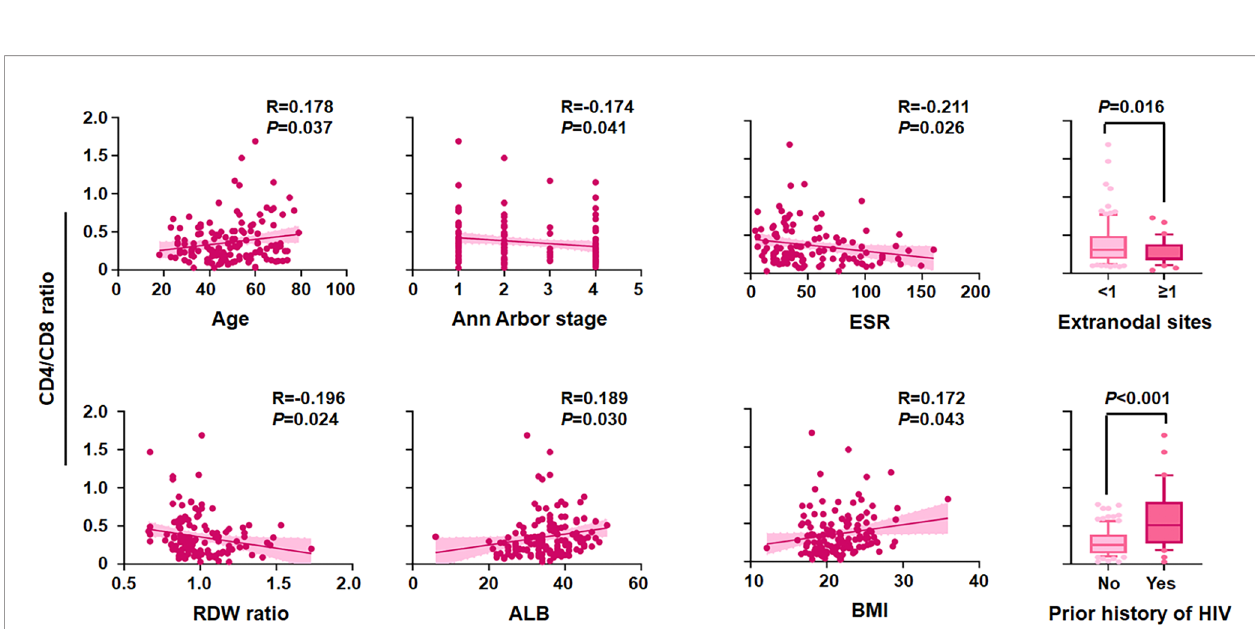
FIGURE 3 | Correlation of the CD4/CD8 ratio with clinical variables. CD4/CD8 ratio level by age, Ann Arbor stage, erythrocyte sedimentation rate (ESR), extranodal sites, red cell distribution width (RDW) ratio, albumin (ALB), body max index (BMI), and prior history of HIV ( n =